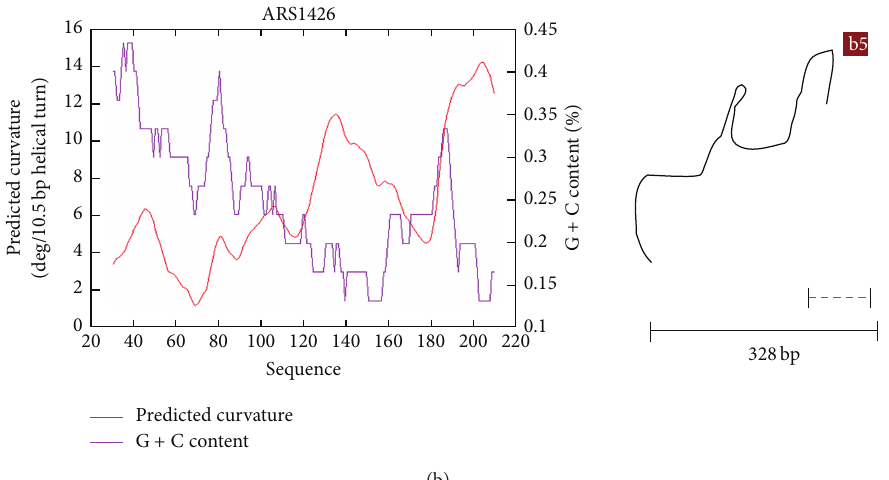
Figure 8: Curvature maps and 2D projection of the amplification promoting sequences. Regions of maximum bending are shown in ARS310 (b1), ARS315 (b2), ARS606 (b3), ARS1305 (b4), and ARS1426 (b5).